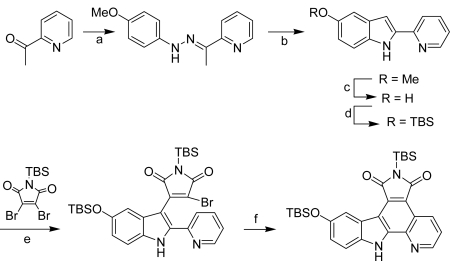
(a) 4-methoxyphenylhydrazine.HCl, t-BuOH, reflux, 4 h. (b) trimethylsilylpolyphosphate, 120°C, 18h. (c) BBr3, CH2Cl2, – 60 °C, then r.t., overnight. (d) (1) Hünig's base, DMF,0 °C, 40 min, (2) TBSOTf, 0 °C, 1 h. (e) (1) LiHMDS, THF, – 15 °C, 45 min, (2) maleimide derivative in THF, – 15 °C for 15 min, (3) r. t. for 45 min. (f) hν, pyrex filter, MeCN, 3 h.